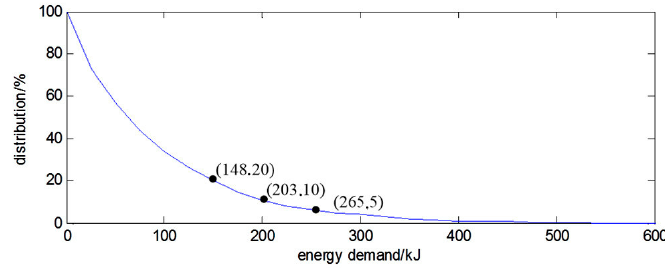
Figure 7. The distribution rate of demand energy value in charge condition.